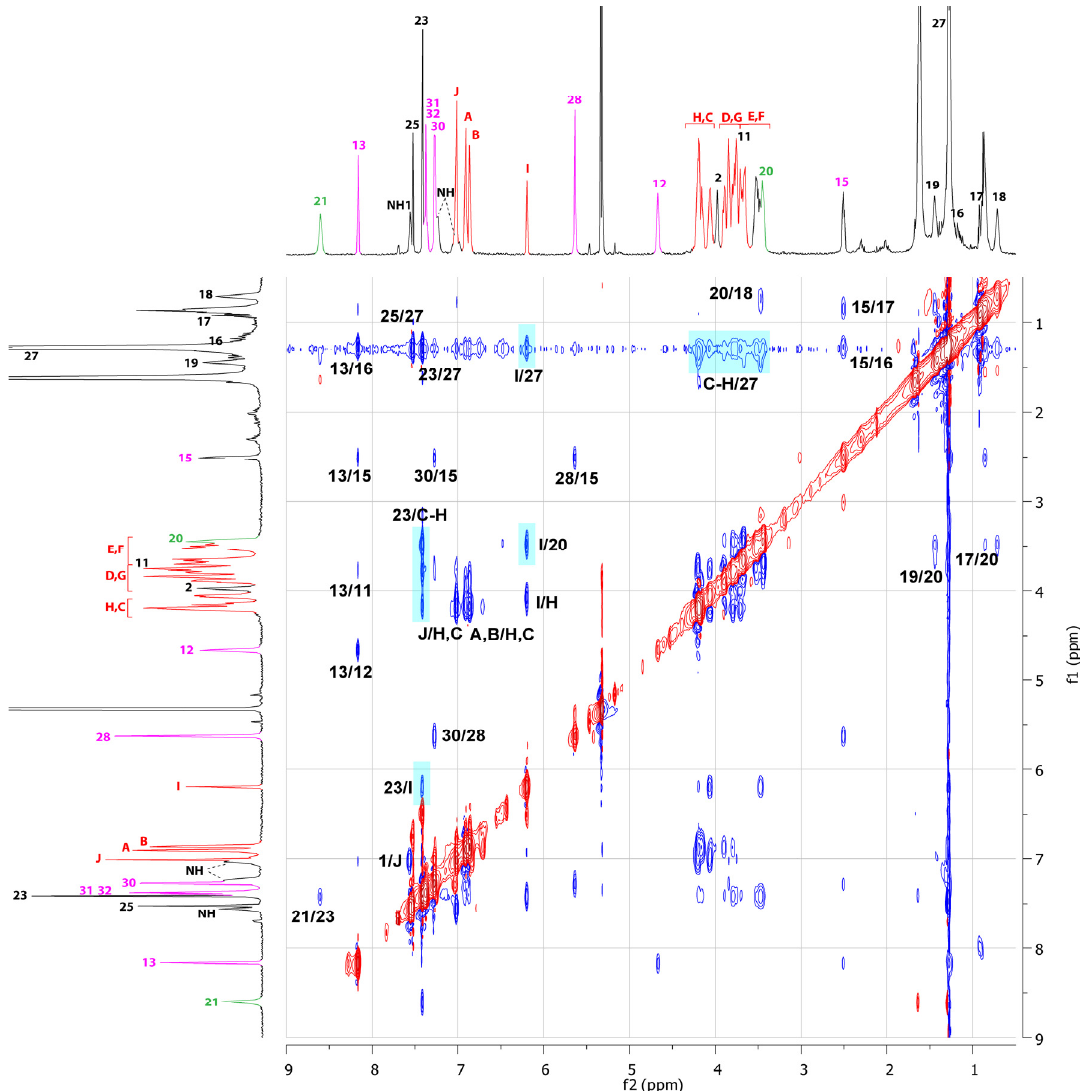
Figure 6. 1 H-NMR ROESY experiment (600 MHz, CD loosened molecular lasso 13 . The coloring, lettering and numbering correspond to the proton assignments indicated in Scheme